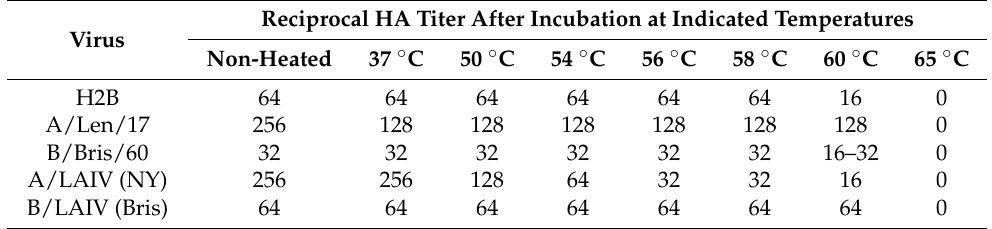
Table 2. HA thermostability test results for the H2B chimeric virus and other viruses under the study. Reciprocal HA Titer After Incubation at Indicated Temperatures Virus